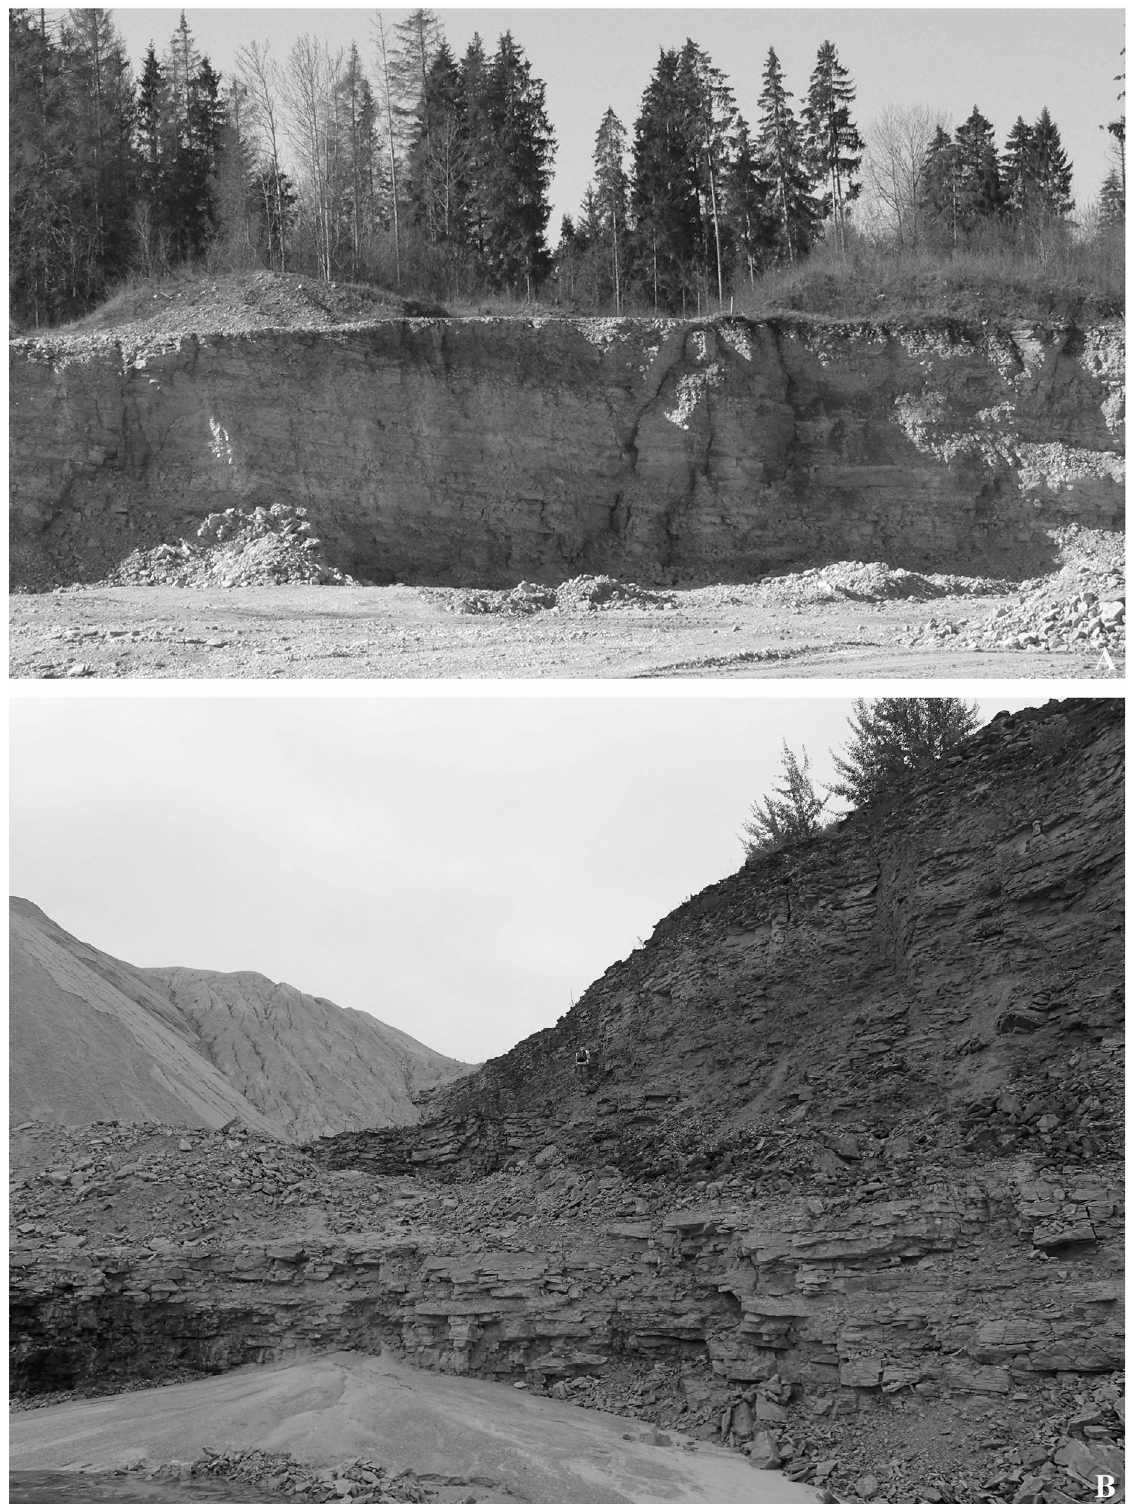
Fig. 3. A , southern wall of the quarry where the west tilted strata are well exposed. B , southeastern wall of the quarry. The lower part of the succession exposed here (below the person in the middle of the photo) contains numerous interbeds rich in algae and many other exceptionally well-preserved fossils. Photos by O.